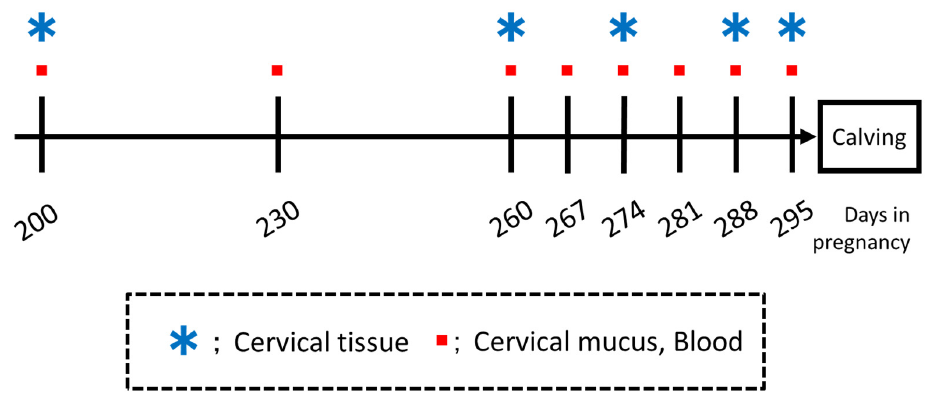
Figure 1. Experimental design.